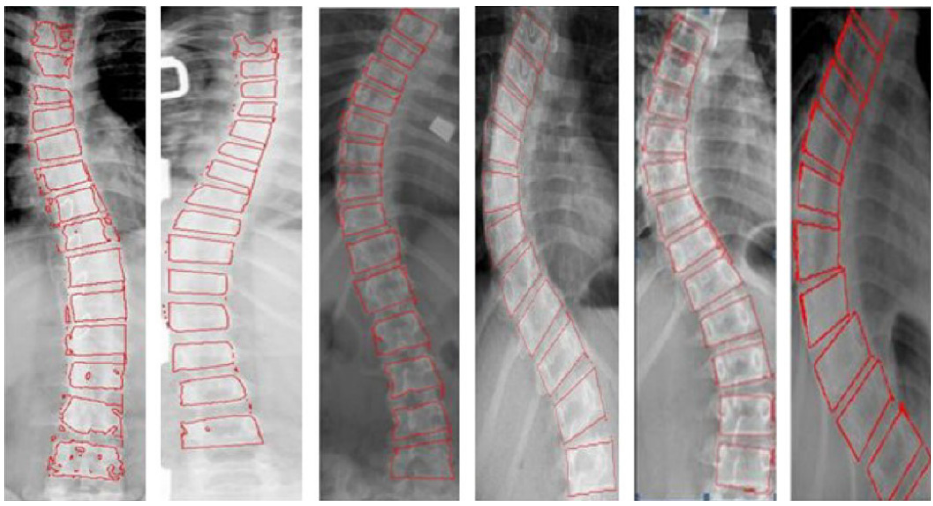
Figure 3. The X-ray images processed by the GVF-snake model [48].